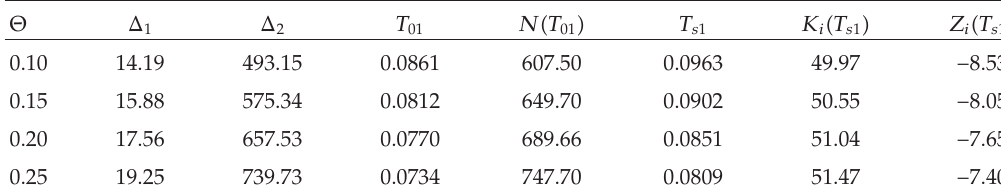
Table 3: E ff ect of deterioration of units on optimal